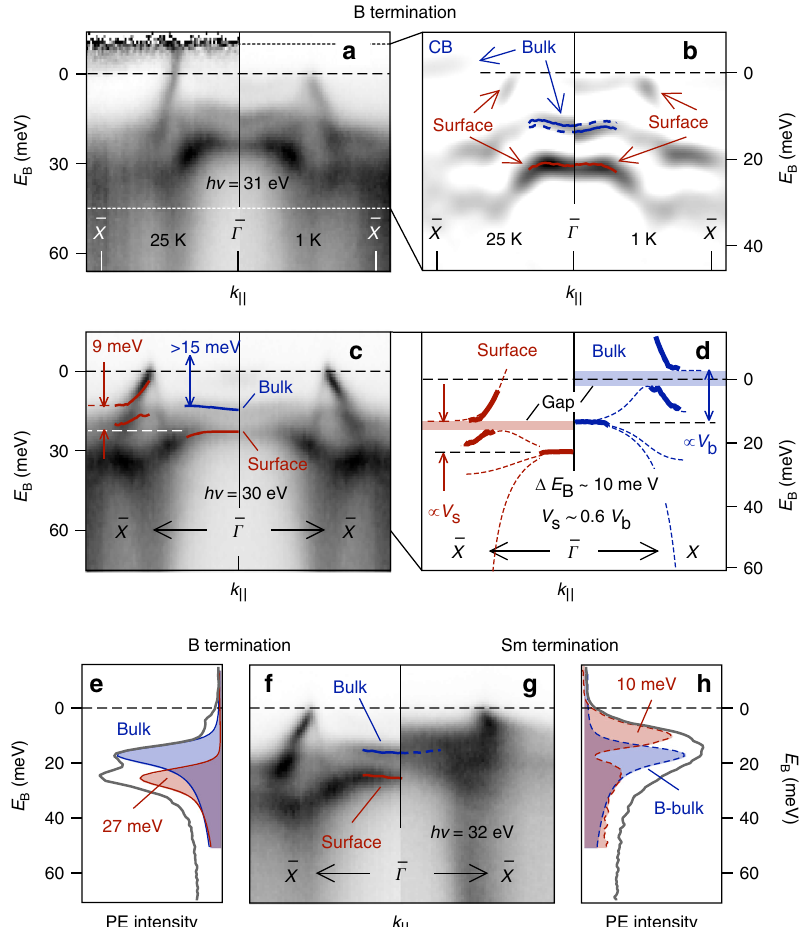
Fig. 2 Surface and bulk contributions to the photoemission intensity. a Evolution of bulk and surface features as a function of temperature. b Second derivative (d 2 I /d E 2 ) of the photoemission intensity shown in a . Solid lines indicate maxima of energy distribution curve fi ts. Dashed lines in b indicate the position of the maxima in the other half of the graph. c Photoemission intensity of the B-terminated surface. Solid lines indicate position of maxima from fi ts of the Doniach – Sunjic function to energy distribution curves. d Surface features from c are reproduced as solid red lines. Dashed lines are guides to the eye, connecting the energy distribution curve maxima in a way similar to the calculated band structure 3 . The estimated bulk structure (blue) is obtained by scaling and shifting of the surface components (see text). Filled areas indicate the width and position of the estimated surface and bulk band gaps. f , g Photoemission intensity for B- and Sm-terminated surfaces. Solid lines indicate maxima of energy distribution curve fi ts. Dashed line in g indicates the position of the bulk component for B termination. e , h Energy distribution curves for B-and Sm termination. Filled curves in e indicate fi ts of Doniach – Sunjic functions. Blue dashed curve in h indicates position of the bulk component from B termination (intensity arbitrarily scaled), red dashed curve shows the residual (surface) spectral weight when the bulk component is subtracted from the spectrum. All results obtained with p